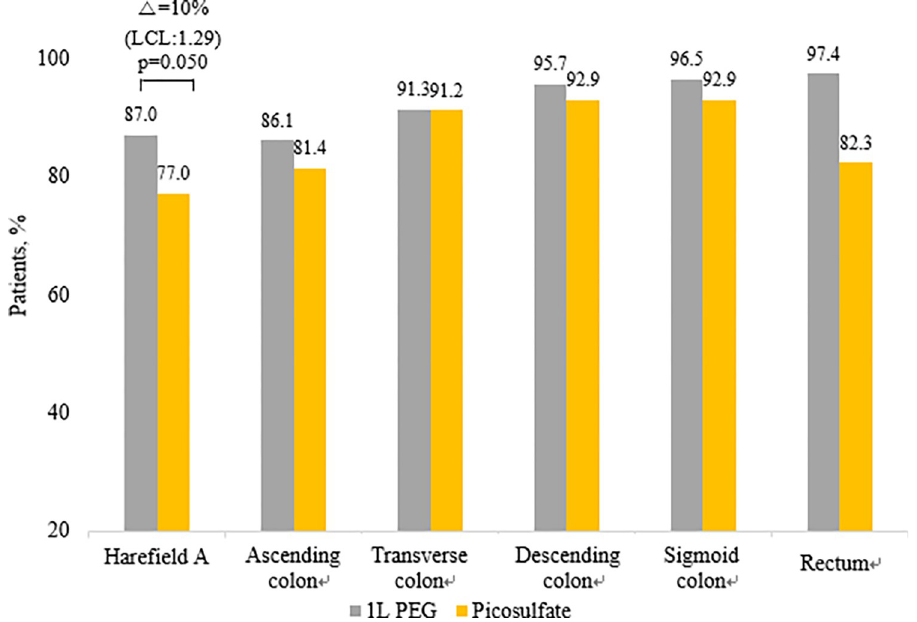
Fig 3. Efficacy of bowel cleansing using the Harefield Cleansing Scale, including overall and segment high-quality bowel cleansing rate. Δ –Difference in efficiency between the 1 L PEG with ascorbic acid group and the PICO with magnesium citrate group; LCL- 97.5% one-sided lower confidence limit for the difference between treatments.